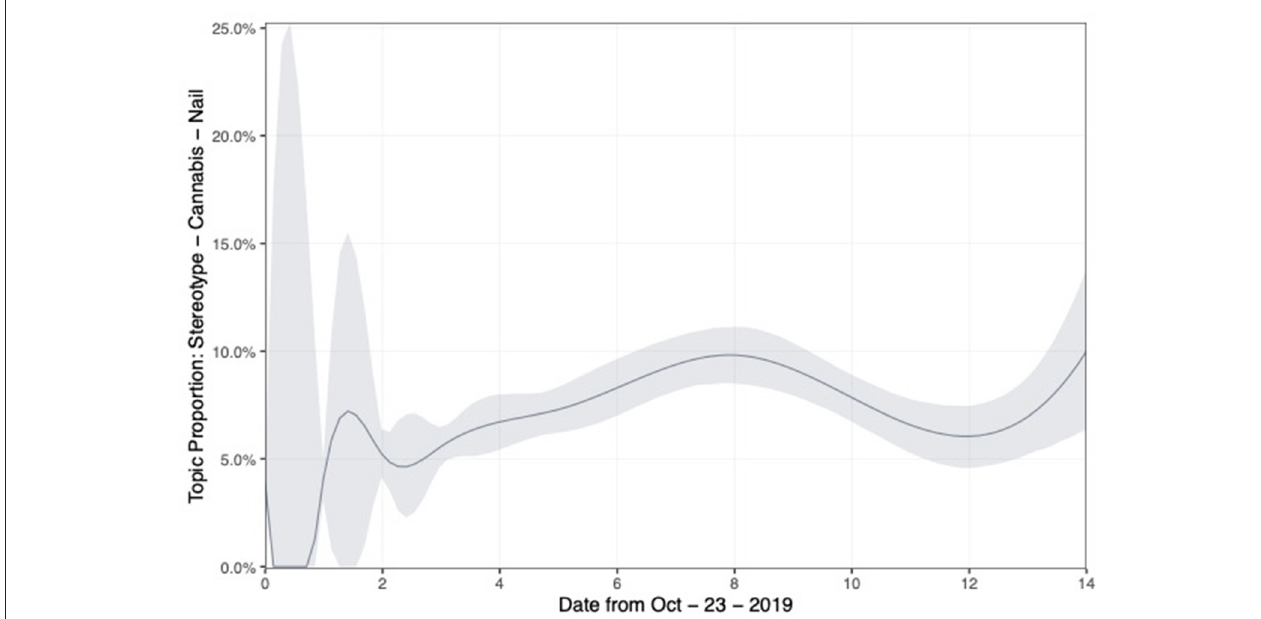
FIGURE 4 | Distribution of tweets the 2 weeks after the event—Topic 18 (Vietnamese